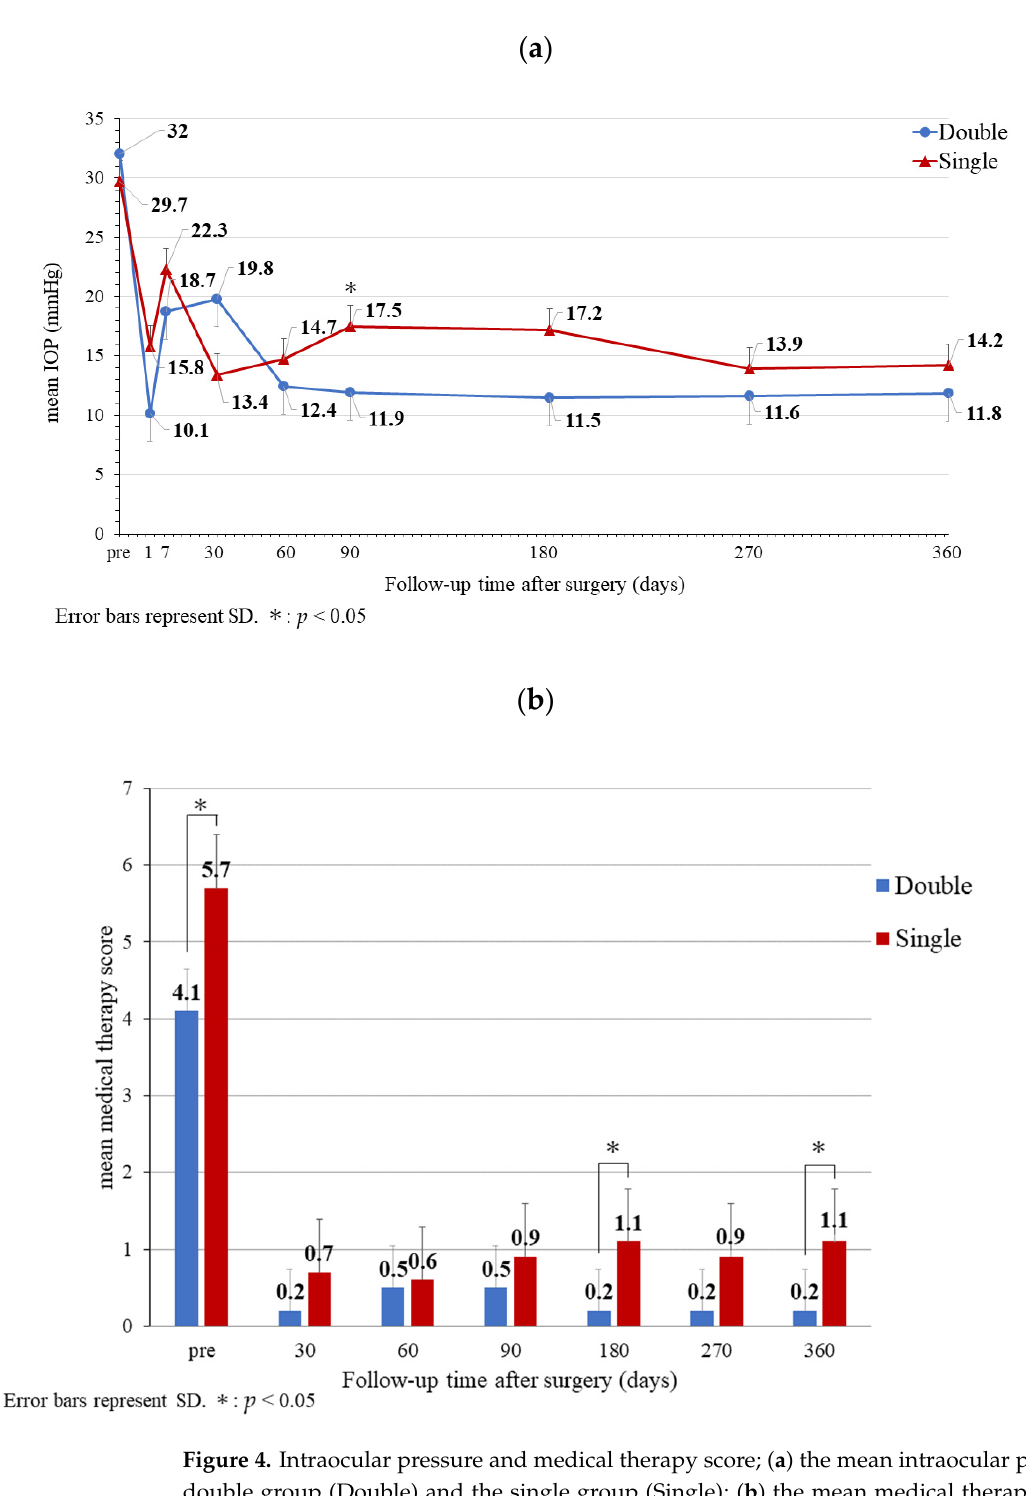
Figure 4. Intraocular pressure and medical therapy score; ( a ) the mean intraocular pressure of the double group (Double) and the single group (Single); ( b ) the mean medical therapy score of the double group (Double) and the single group